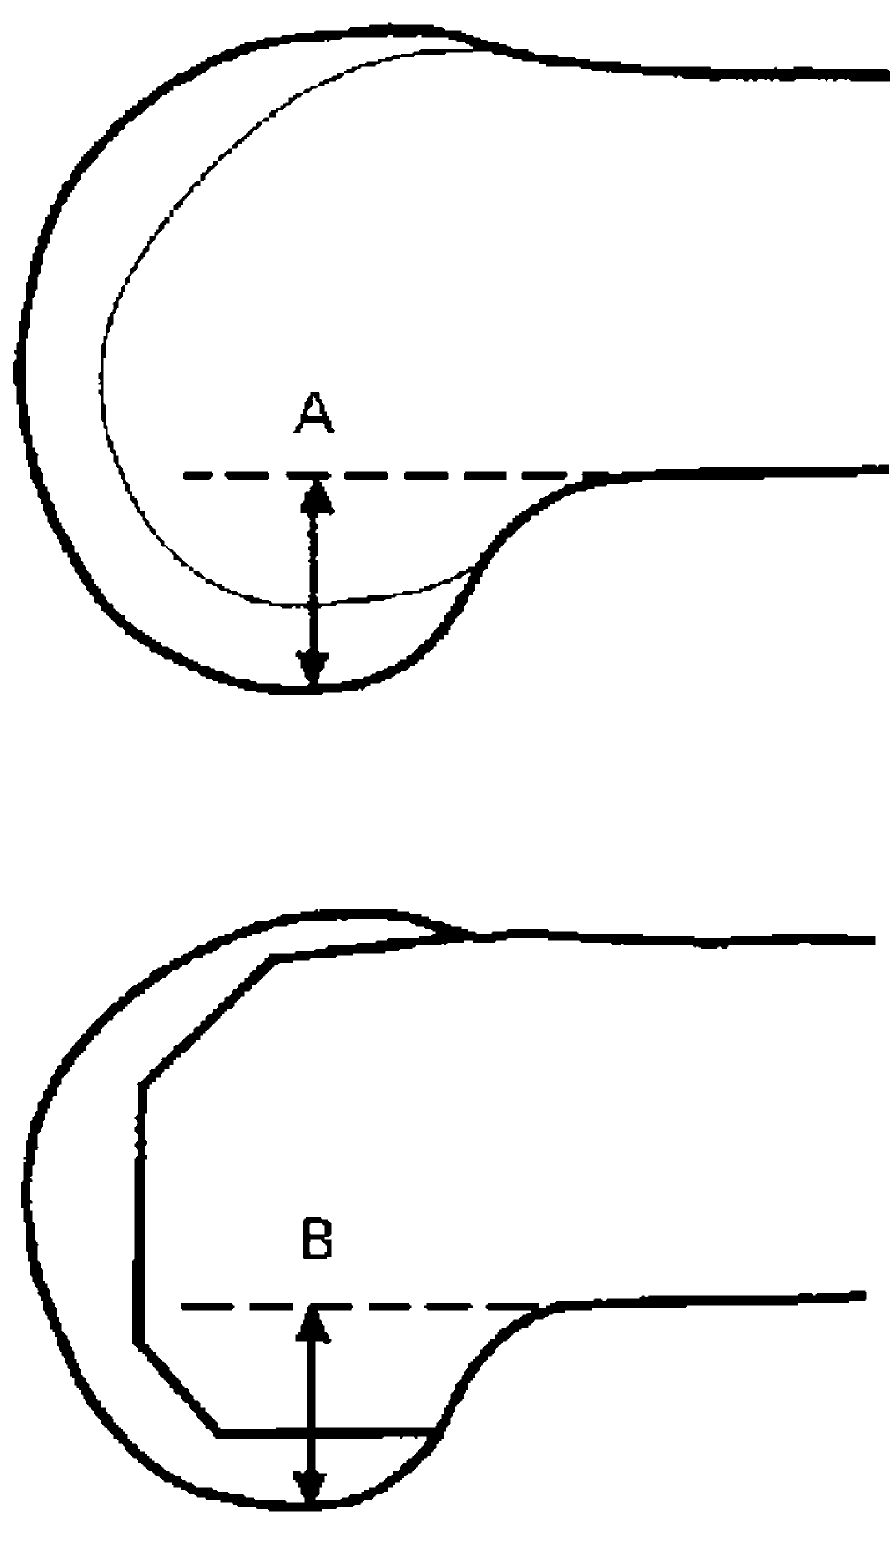
Fig 3. Posterior offset measurement. Diagram showing the measurement of posterior condylar offset (A) before and (B) after operation.